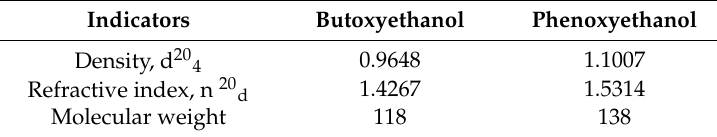
Table 1. Physico-chemical properties of ethoxylated alcohols.